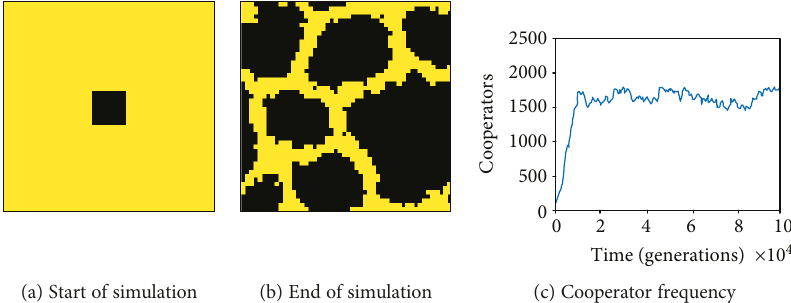
Figure 11: Evolution of cooperator frequency (black) when starting with an initial 8 × 8 cooperator cluster within a 50 × 50 grid of defectors (yellow).